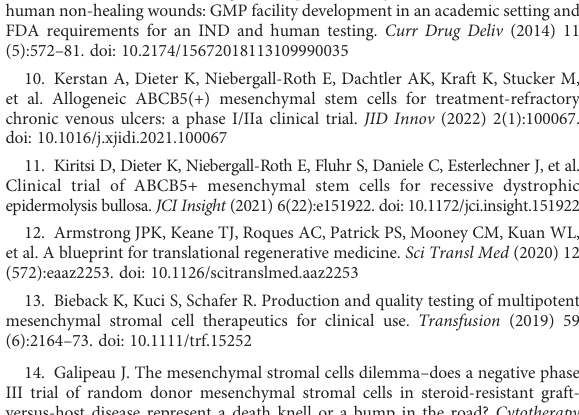
SUPPLEMENTARY FIGURE 1 All hMSC pools display similar adipogenic and osteogenic differentiation potential. hMSCs were seeded at a density of 1,000 cells/cm 2 and grown to subcon fl uency. Adipogenic differentiation was induced using the hMSC Adipogenic Differentiation Medium BulletKit (Lonza), or osteogenic differentiation was induced using osteogenic medium composed of a -MEM/ 10%FBSsupplementedwith1 m Mdexamethasone,50 m Mascorbicacid,and10 mM b -glycerolphosphate (Sigma – Aldrich). After 3 weeks under differentiation conditions,lipidvacuolesinadipogeniccultureswerestainedwithoilredOand calcium deposits of osteogenic cultures with alizarin red S, respectively. SUPPLEMENTARY FIGURE 2 hMSCs migrate out of diluted fi brin glue. Instead of being applied to a wound, hMSCs were seeded in fi brin glue into a cell culture well plate and cultivatedinmediumsupplementedwithhPLversusserum-freemediumas control. 4.5 hours post-seeding, hMSCs migrated from the glue attaining their typical fi broblast-like morphology. hMSCs in serum-free medium showed no migration out of the gel. (Axio Vert.A1, 5-fold magni fi cation). SUPPLEMENTARY FIGURE 3 No systemic wound healing effect after topical hMSCs application. Rats were wounded and hMSCs applied topically in diluted fi brin glue. Comparison of wound size reduction of contralateral untreated wounds with lateral either (A) untreated, (B) hMSCs cryo single application, (C) fi brin glue single application, (D) single application hMSCs fresh, (E) repeated application of fi brin glue or (F) repeated application of hMSCs fresh d0, 4 and 8. Quanti fi cation of the wound area was performed with Image J. ** p ≤ 0.01, as calculated using two-way ANOVA und Sidak-Test. SUPPLEMENTARY TABLE 1 Trophic factors content in hPL MultiPL ’ 100i (batch 11219267DM), including batch release test results. Experiments performed on two different bags (#209 and 221) from the used MultiPL ’ 100i batch 11219267DM, means and standard deviations are shown. 1 Experiments repeated twice with different controls and veri fi ed using ELISA kits from two different companies. bFGF,